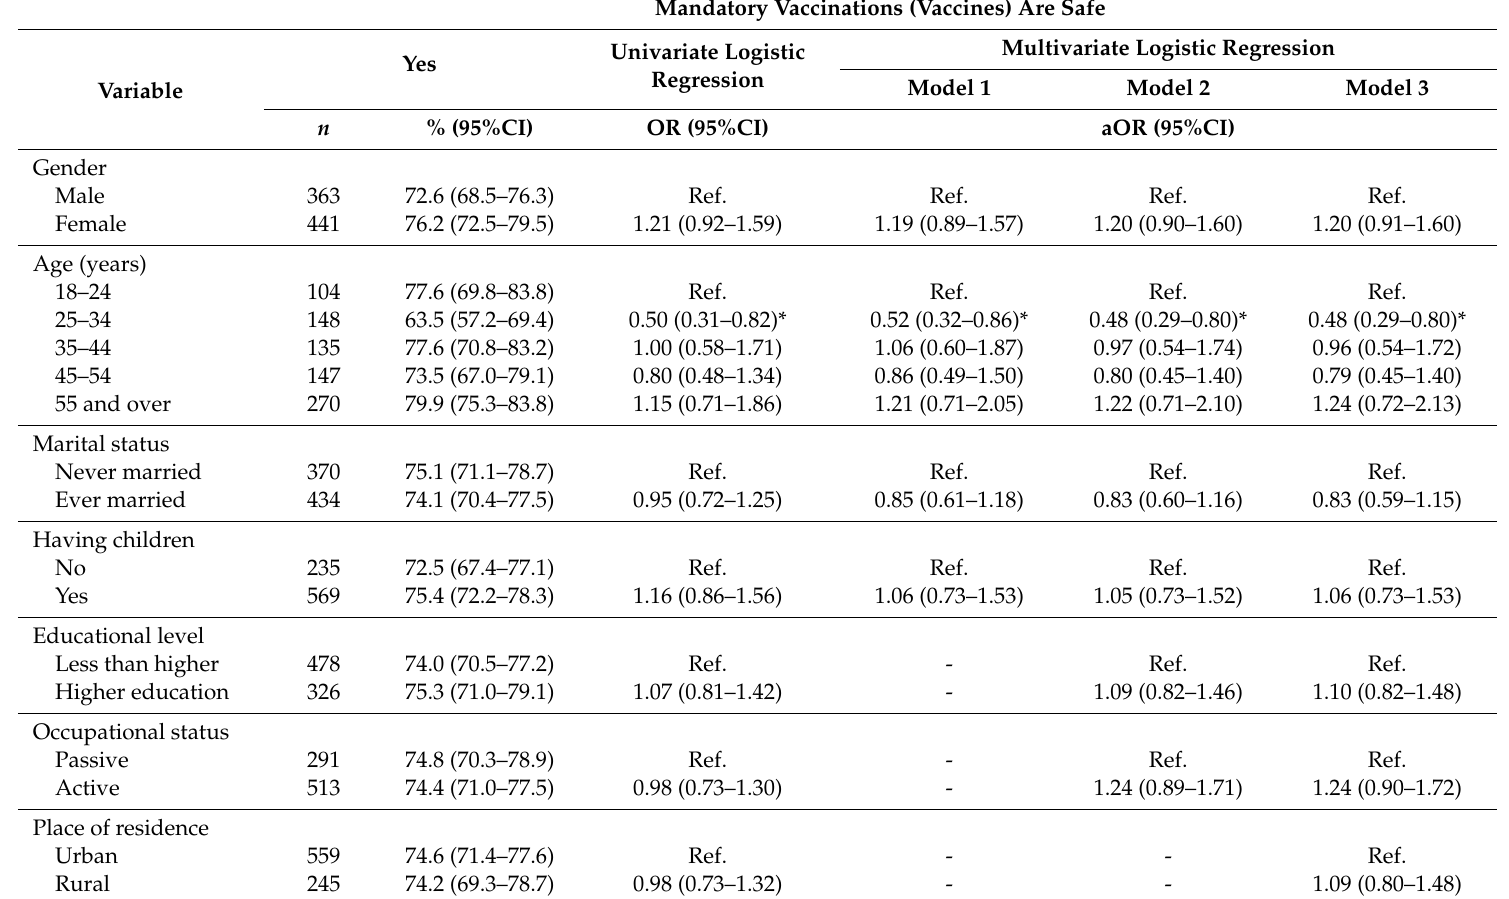
Table 2. Socioeconomic factors associated with vaccine confidence ( n =